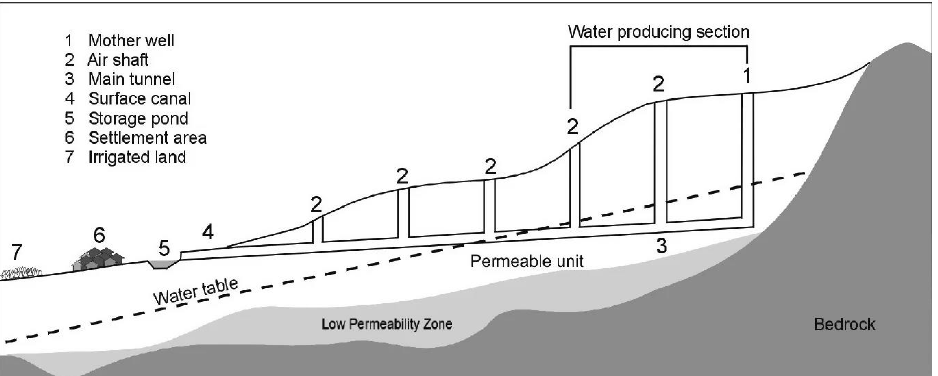
Figure 2. The structural schematic diagram of the karez system is a longitudinal section that shows the various components of the karez system, such as the mother well, vertical wells, dragon mouths, open canals, and water tanks. This diagram is adapted from Abudu’s work